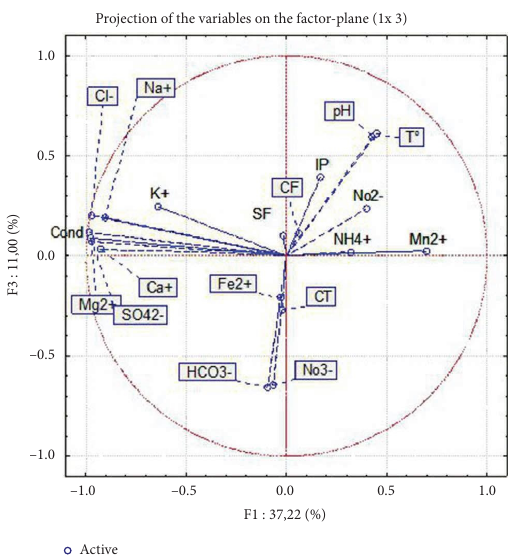
Figure 4: Distribution of parameters on the factorial plane ( F 1– F 3) of the Angads aquifer in September 2020.